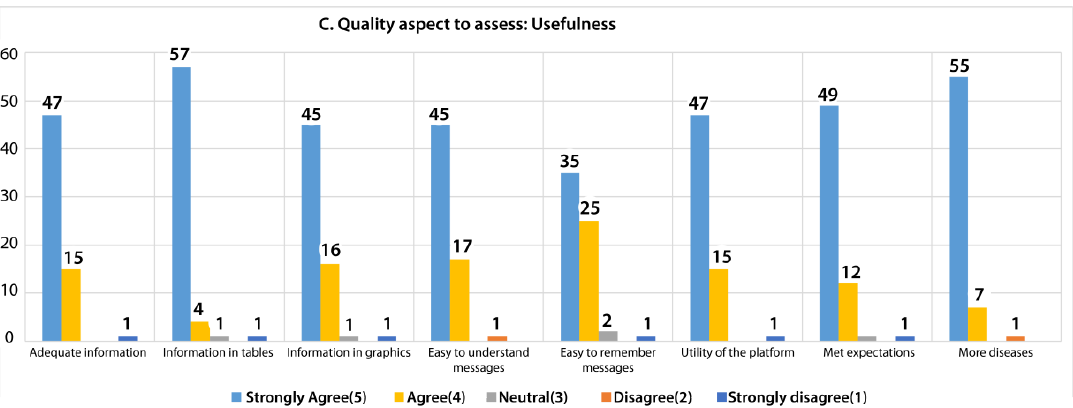
Figure 20. Evaluation of users about the usefulness criteria.